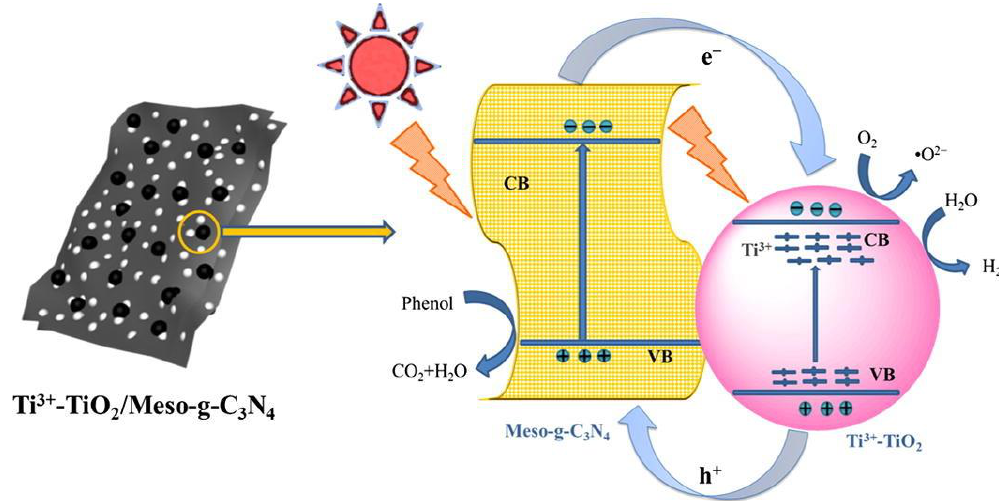
Figure 13. Possible visible light photocatalytic mechanism of Ti 3+ -doped meso–TiO 2 /g–C 3 N 4 composites for hydrogen production. Reproduced from [90] . Copyright (2017), Elsevier.